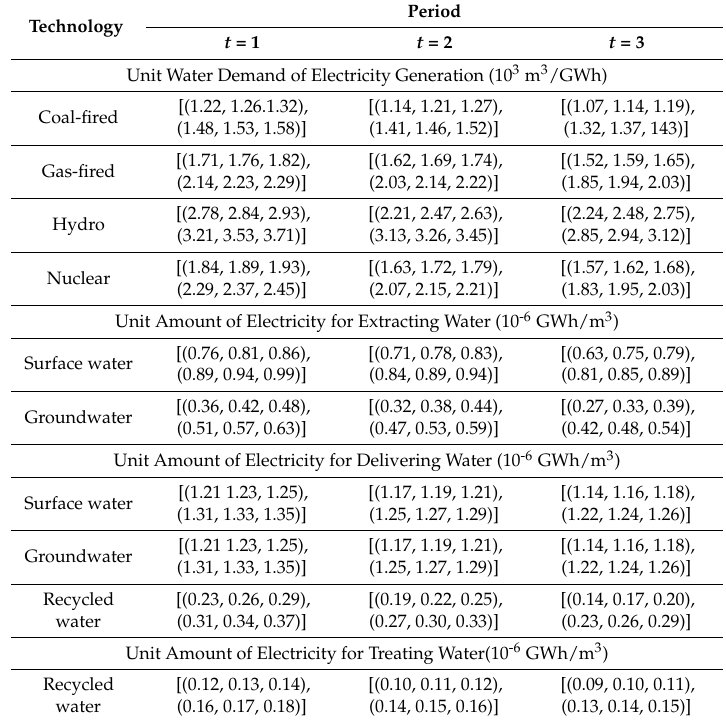
Table 2. Energy-water nexus related